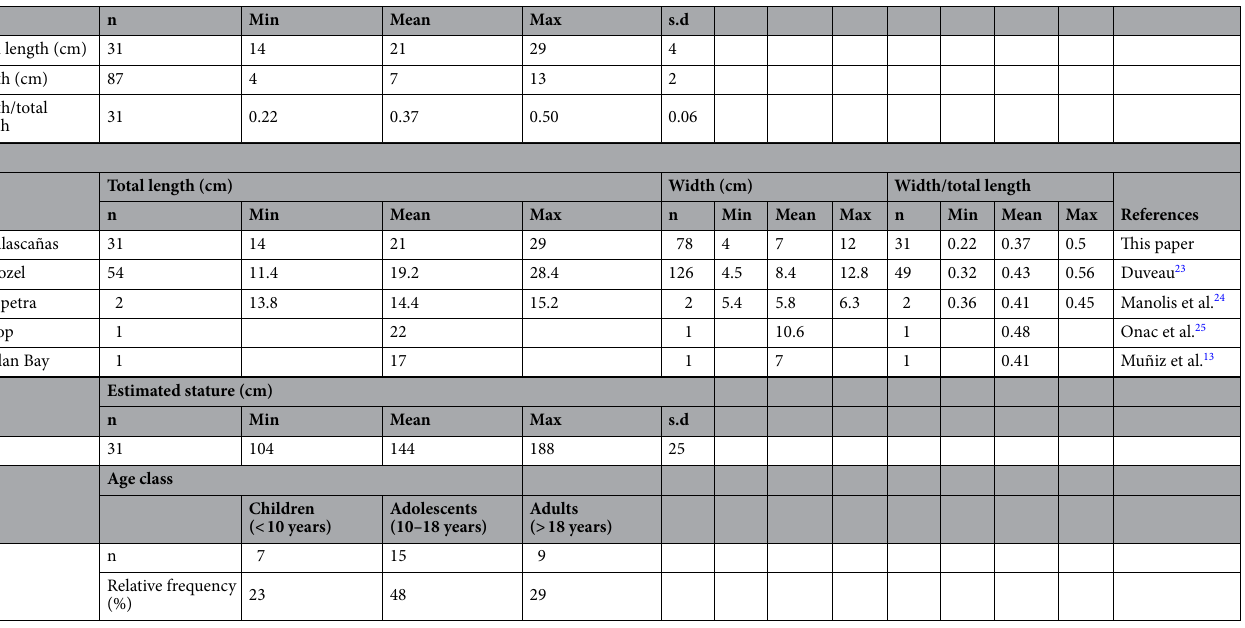
Table 1. Measurements of Matalascañas’ footprints. ( a ) Range of values. ( b ) Size comparison with other sites. ( c ) Estimated stature. ( d ) Estimated hominin group composition.